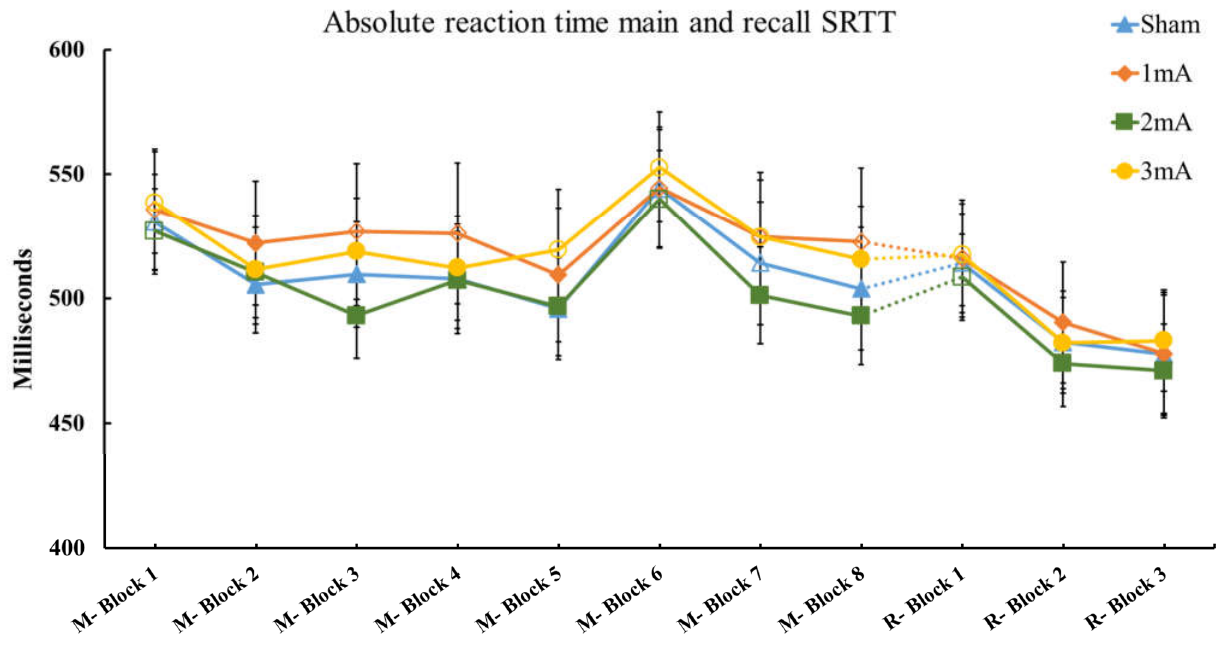
Figure 4. Absolute reaction time M-SRTT and R-SRTT. The graph displays the absolute reaction time of main and recall SRTT in all conditions.